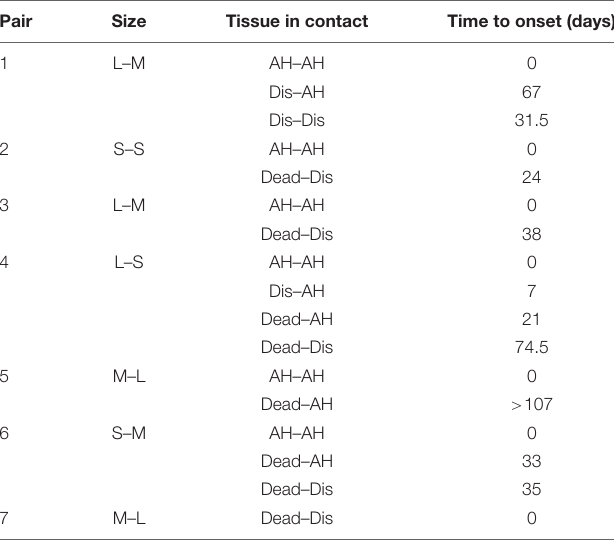
TABLE 1 | Development of colony condition through time for the contact colony pairs at Picudas